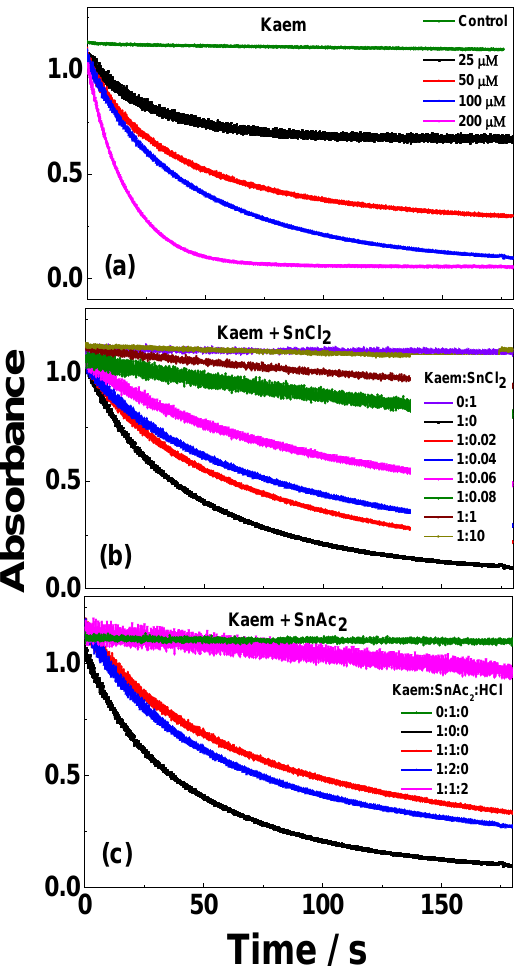
Figure 5. Time evolution of absorbance at 517 nm for 100 µ M 2,2-diphenyl-1-picrylhydrazyl (DPPH • ) scavenged by ( a ) 25, 50, 100, and 250 µ M HKaem; ( b ) 100 µ M HKaem, 100 µ M SnCl 2 , and solutions of